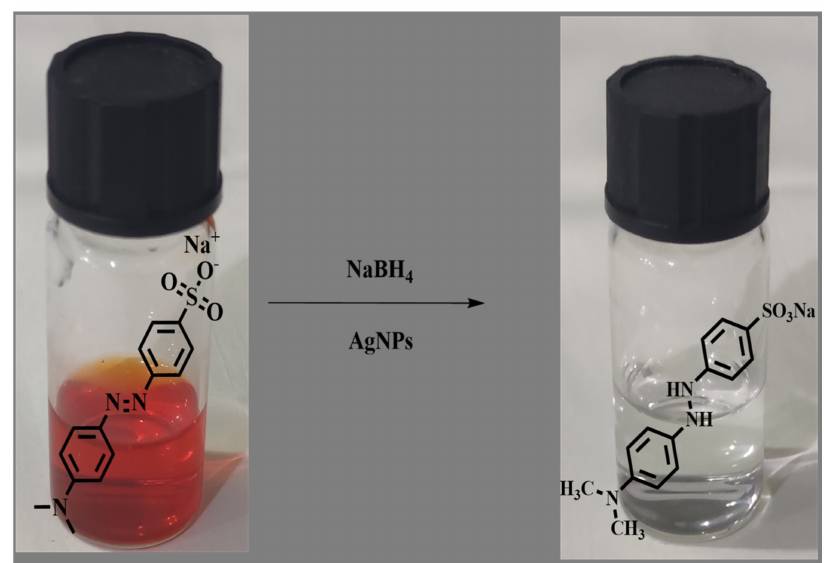
Figure 15. Possible mechanism of catalytic activity of Methyl